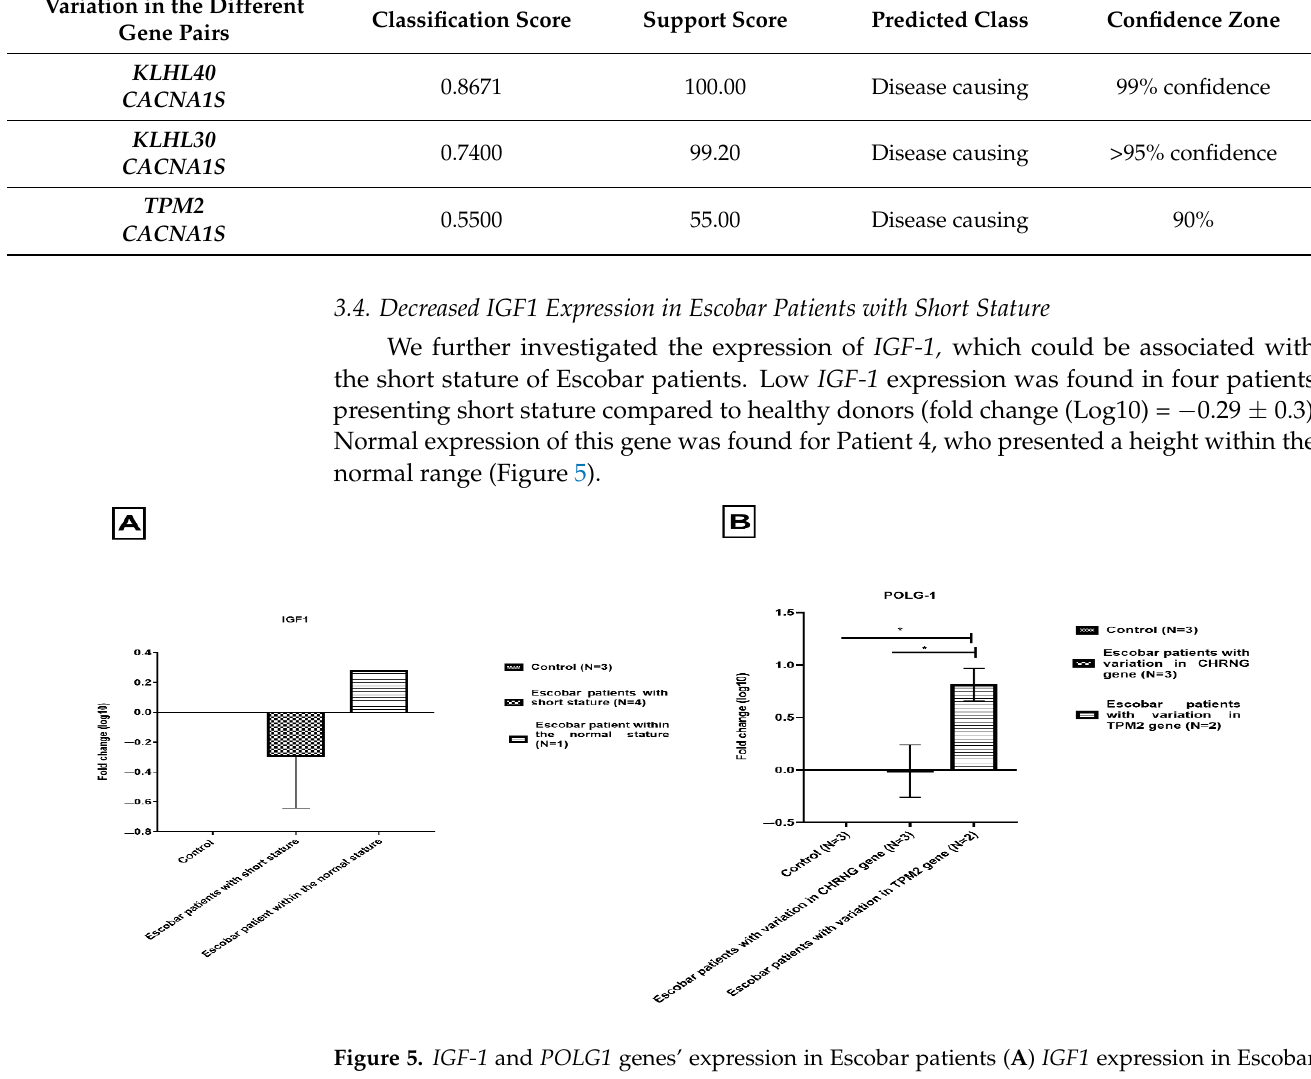
Table 4. Disease-causing digenic combinations scores of oligogenic interaction of the different genes found in Patient 3 using Orval tool.